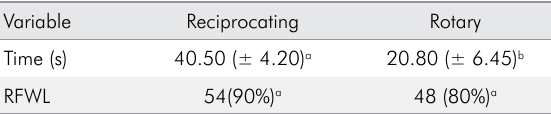
Table 1. Mean and standard deviations of time (seconds - s), (absolute and percentage frequency of pathfinding instruments to reach the full working length (RFWL) using different kinematics.